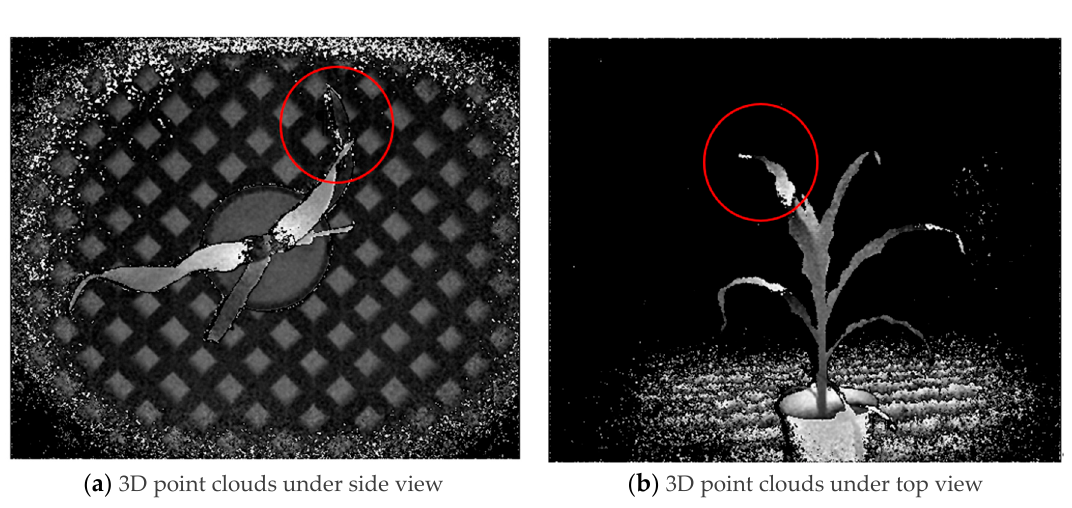
Figure 14. 3D point clouds acquired by Kinect v 2.0 sensor.